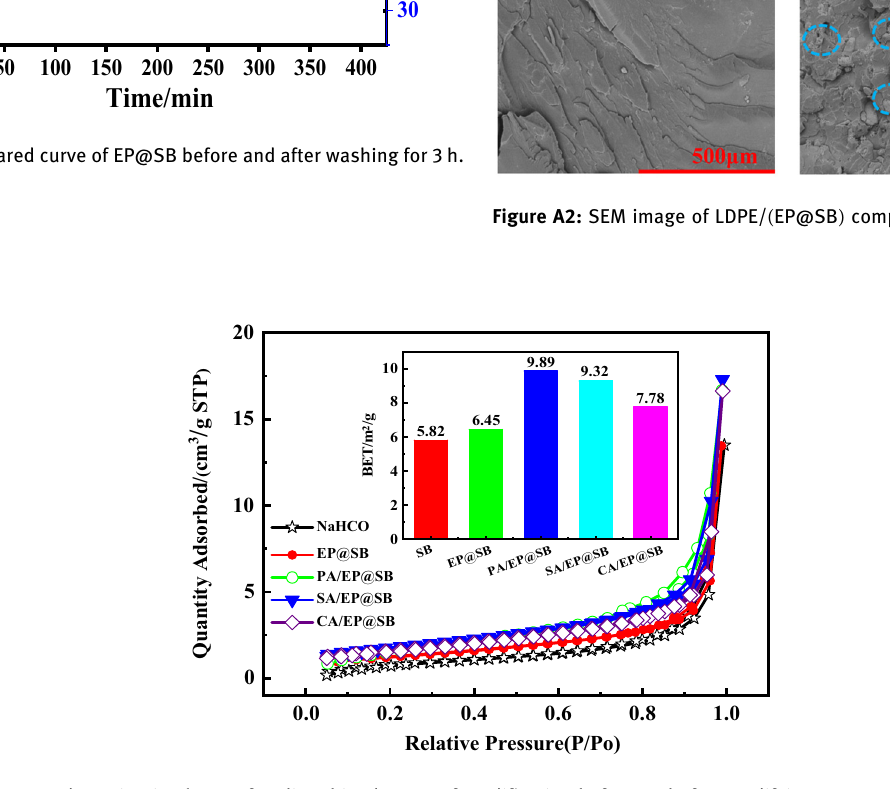
Figure A3: Nitrogen adsorption isotherm of sodium bicarbonate of modi fi cation before and after modifying.